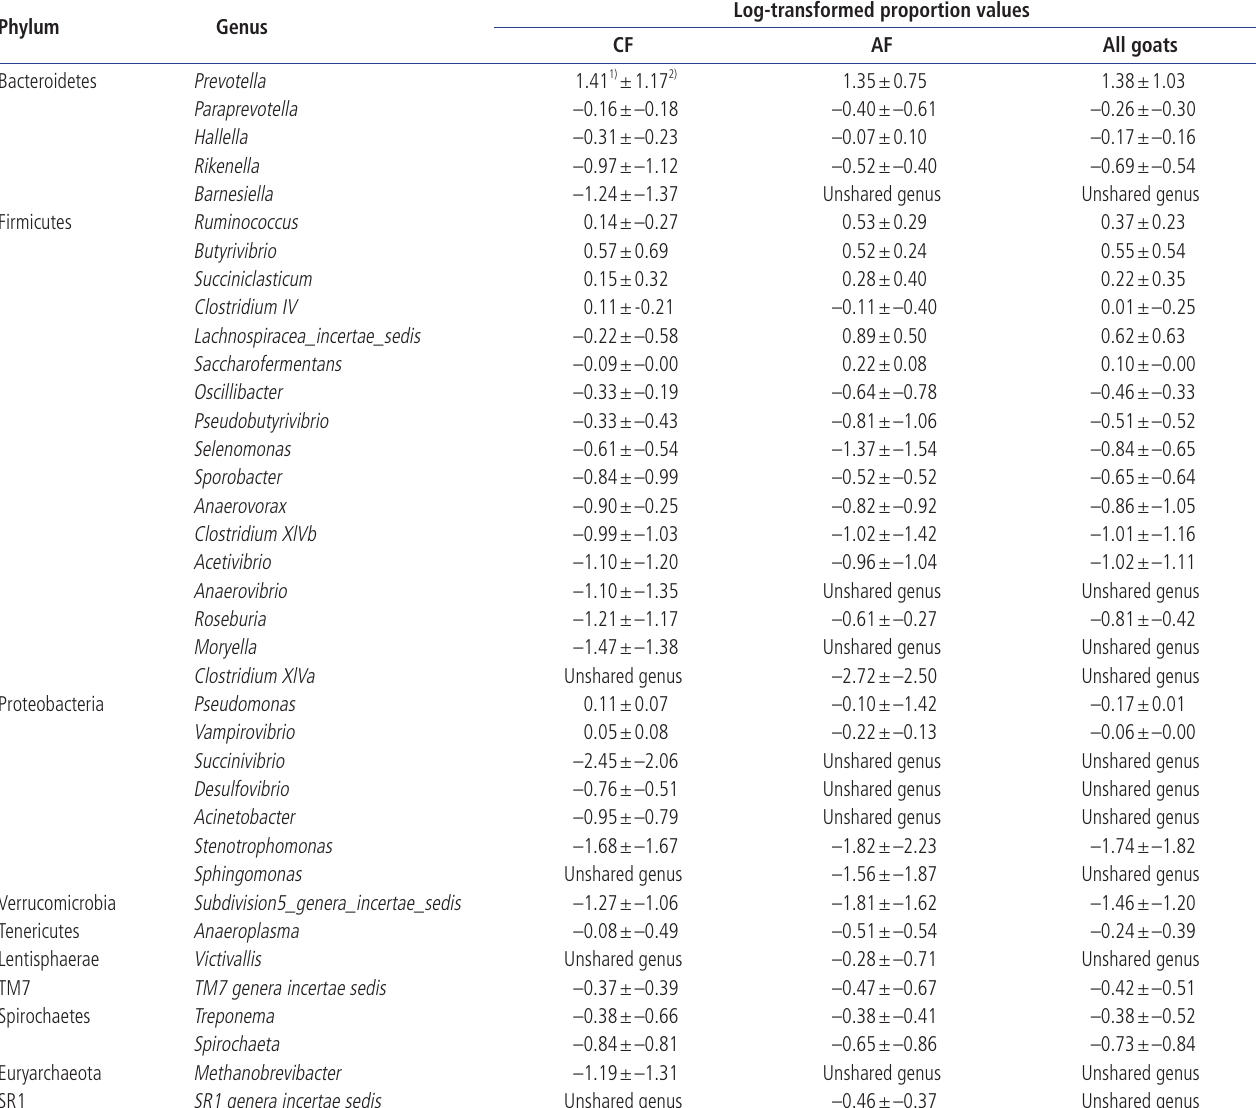
Table 4. There were 33-shared genera in the rumen of goats fed at a completed feed (CF) diet and 30 fed all forage (AF) diet as well as 26 shared by all goats